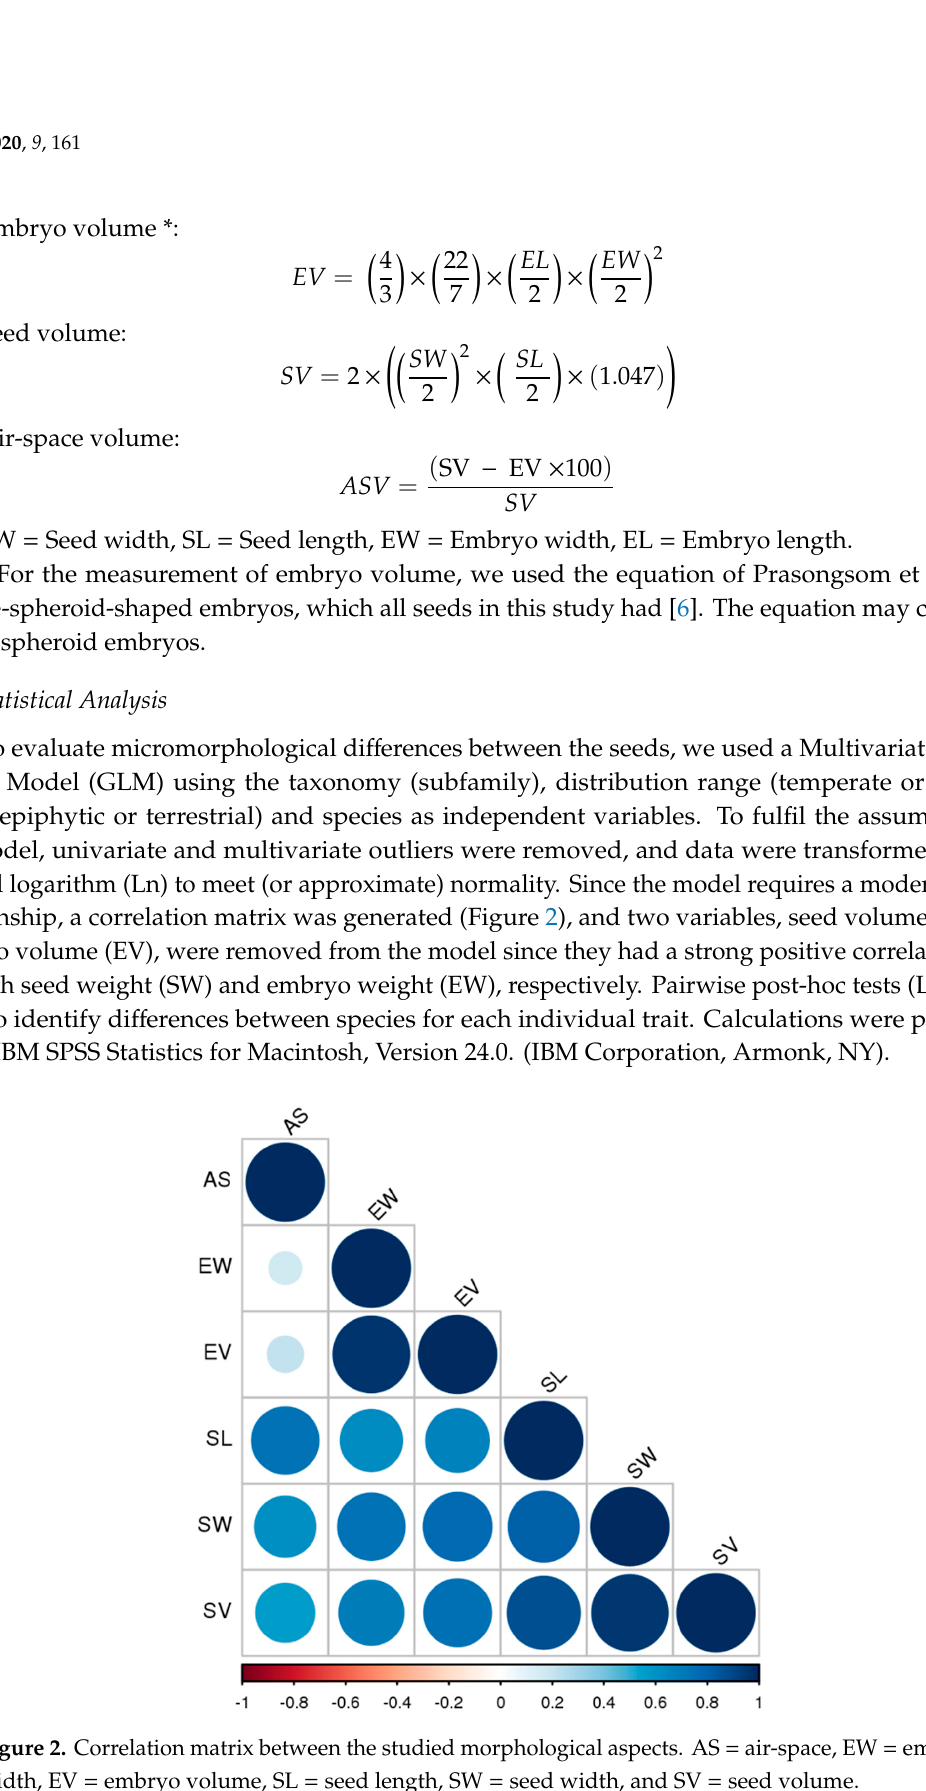
Figure 3. Correlation matrix between measurement ratios: EL = Embryo length, EW = embryo width, SL = seed length, SW = seed width, SV = seed volume, and EV = embryo volume. 5. Conclusions Our results show some similarities in qualitative traits (pod colour and size and seed colour) among taxonomically related orchid species. However, there was high variation in orchid seed morphometrics, likely because of ecological adaptations to their unique habitats and modes of dispersal. Information on orchid seed morphometrics is useful to infer the optimal dispersal mode, related to in situ conservation strategies and may help identify vulnerable species and set priorities for ex situ conservation. Further research including additional orchid species is needed to validate these results, and to explore other properties of the studied seeds (e.g., lipid composition) to develop optimal storage protocols for seed banking. Supplementary Materials: The following are available online at www.mdpi.com/2223-7747/9/2/161/s1, Table S1: The plant taxonomy, morphology, biogeographical origin, and ecological habits for each species. Author Contributions: All authors (S.D., A.C.M., C.M., J.M., J.N., H.W.P.) contributed to the conceptualization and experimental design. S.D. collected the data. S.D. and A.C.M. analyzed the data and wrote the original draft. All authors have read and agreed to the published version of the manuscript.